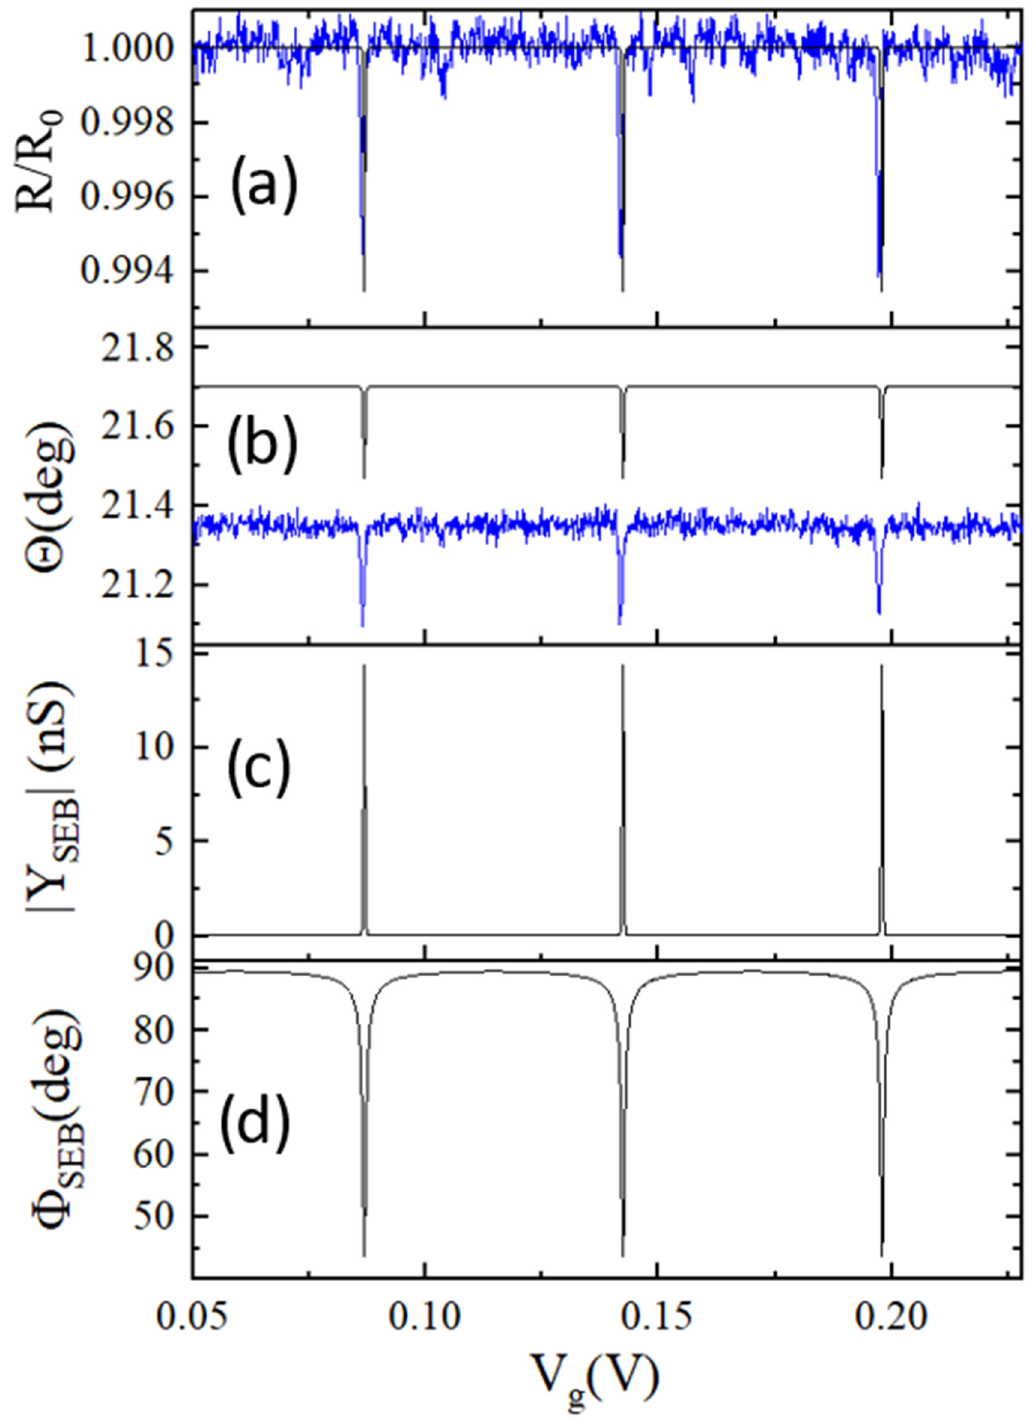
Figure 8. Experimentally obtained reflectometry data (blue lines) along with simulations (black lines) 8 for magnitude ( a ) and phase ( b ) of the RF signal reflected from SEB. Base temperature of the fridge is 25 mK. Both curves are obtained by averaging of 3049 scans; e ff ective bandwidth is 2.7 kHz. Caclulated oscillations of admittance magnitude ( c ) and phase ( d ) using Formula (2) from Section 2. Parameters used in simulations: C g = 2.88 aF, C J = 65 aF, R J = 45 k Ω , T = 50 mK. The calculated phase response is o ff set by a constant ( − 40 degrees) for easy